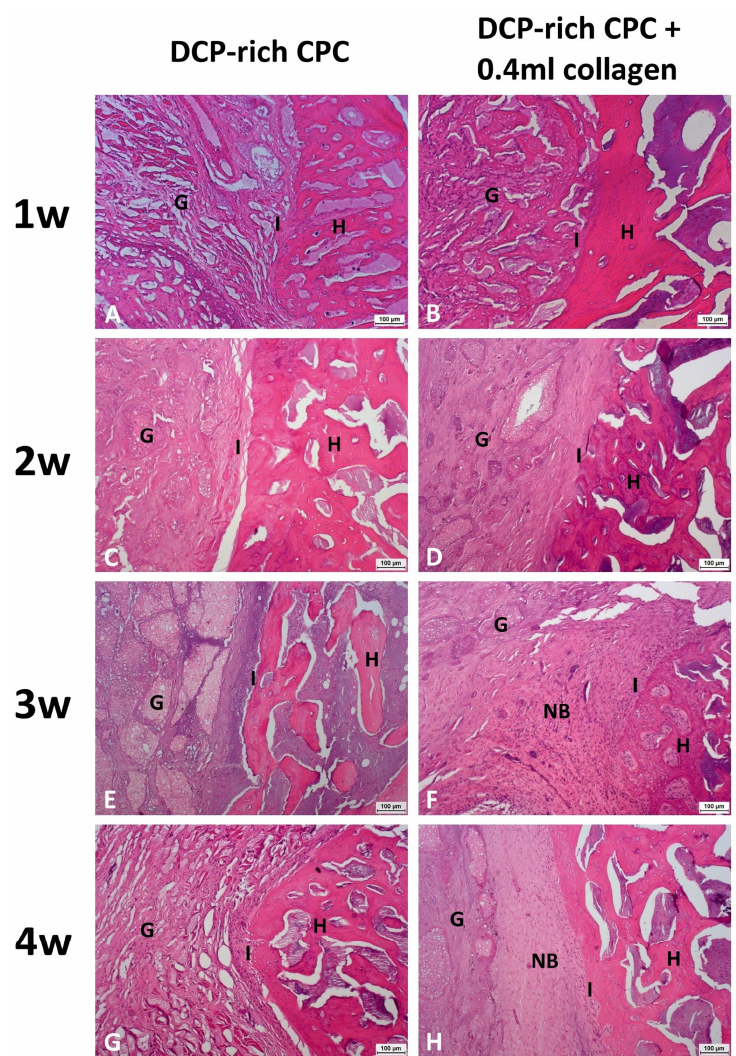
Figure 7. Representative histological coronal sections between the L4 and L5 transverse processes stained with haemotoxylin and eosin. ( A ), ( C ), ( E ), and ( G ) represented 1–4 weeks post-surgery of DCP-rich CPC group (100×). ( B ), ( D ), ( F ), and ( H ) represented 1–4 weeks post-surgery of DCP-rich CPC supplemented with 0.4 mL collagen group (100×). Scale bar = 100 μ m. Abbreviation: G, implanted graft; H, host bone; I, interface between host bone and implanted graft; NB, new bone formation.